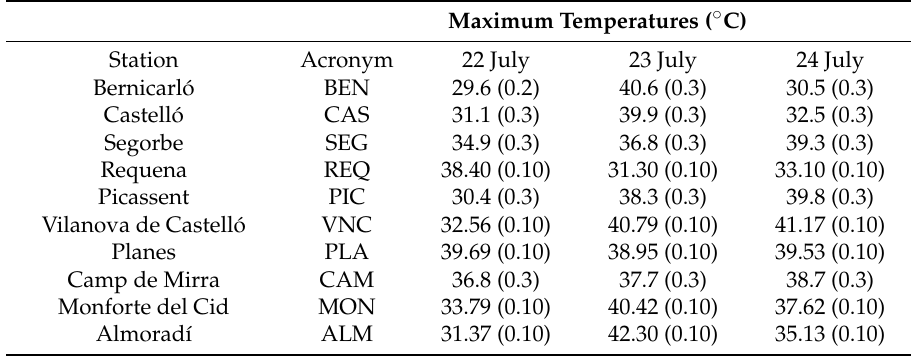
Table 2. Observed maximum temperatures ( ˝ C) and measurement accuracy at different representative stations for each day of simulation within the whole intense-heat weather